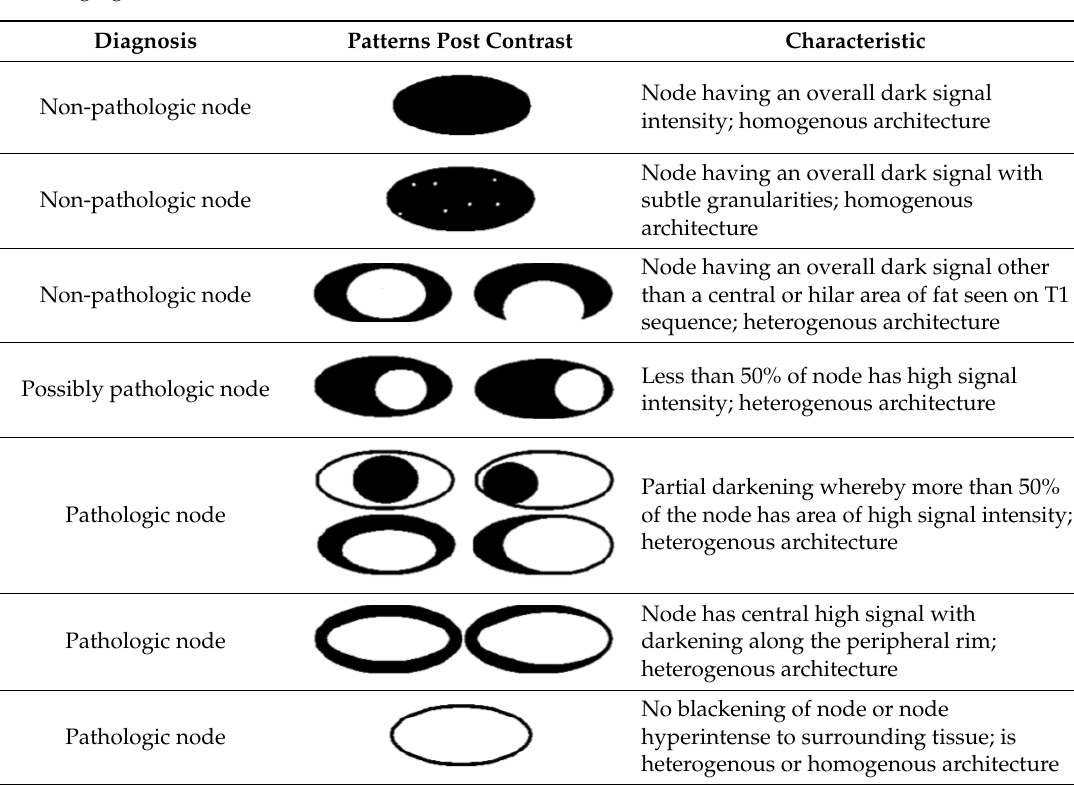
Table 2. Patterns of lymph node enhancement for ferumoxtran 10-enhanced magnetic resonance imaging [27].